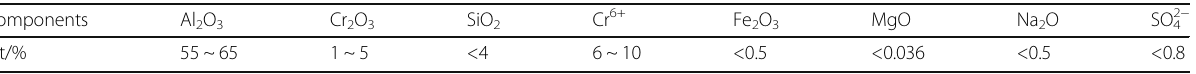
Table 1 The components of the chromium-containing alumina sludge Components